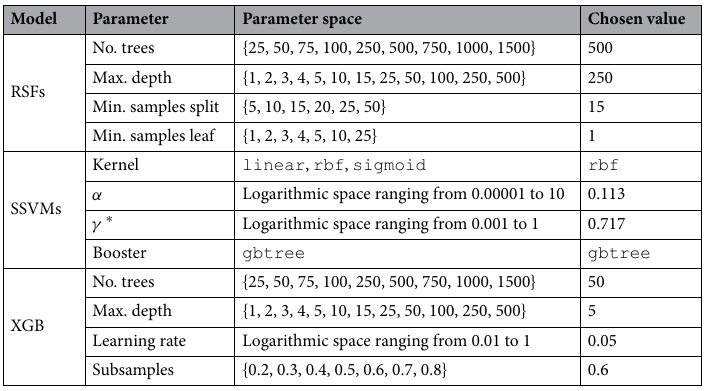
Table 2. Models’ parameters. Each model was parametrized using a randomized search of 25 different parameter settings with a 10-fold cross validation to maximize the c -index.* γ is only relevant for the rbf kernel. It was ignored for the